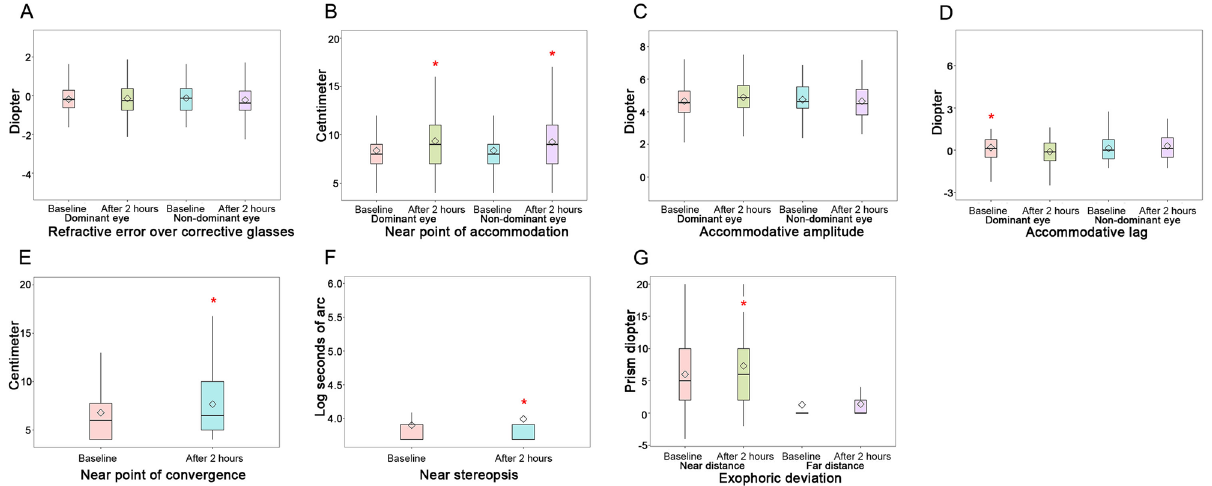
Figure 1. Changes in visual parameters after a 2-h virtual reality gaming session; ( A ) refraction with glasses, ( B ) near point of accommodation ( C ) accommodative amplitude, ( D ) accommodative lag, ( E ) near-point convergence, ( F ) near stereopsis, and ( G ) exophoric deviation at the near and far distances.